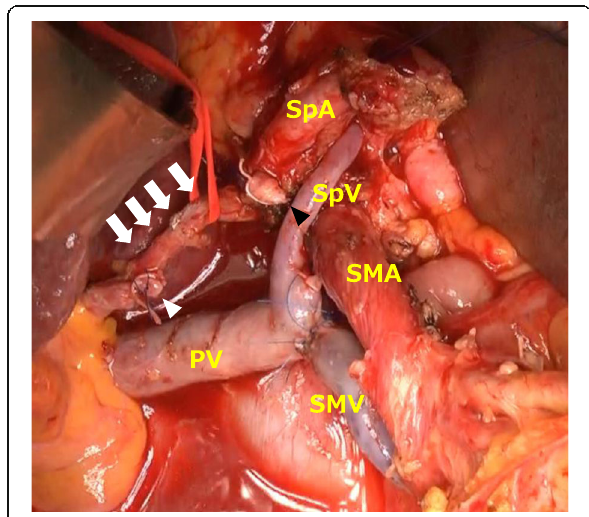
Fig. 3 During the operation, anastomosis between the CHA and PHA was observed (white arrow). The anastomotic site became enlarged after dissection of the CHA. The black arrowhead shows the stump of the CHA. The white arrowhead shows the stump of the PHA. SpV, splenic vein; PV, portal vein; SMV, superior mesenteric